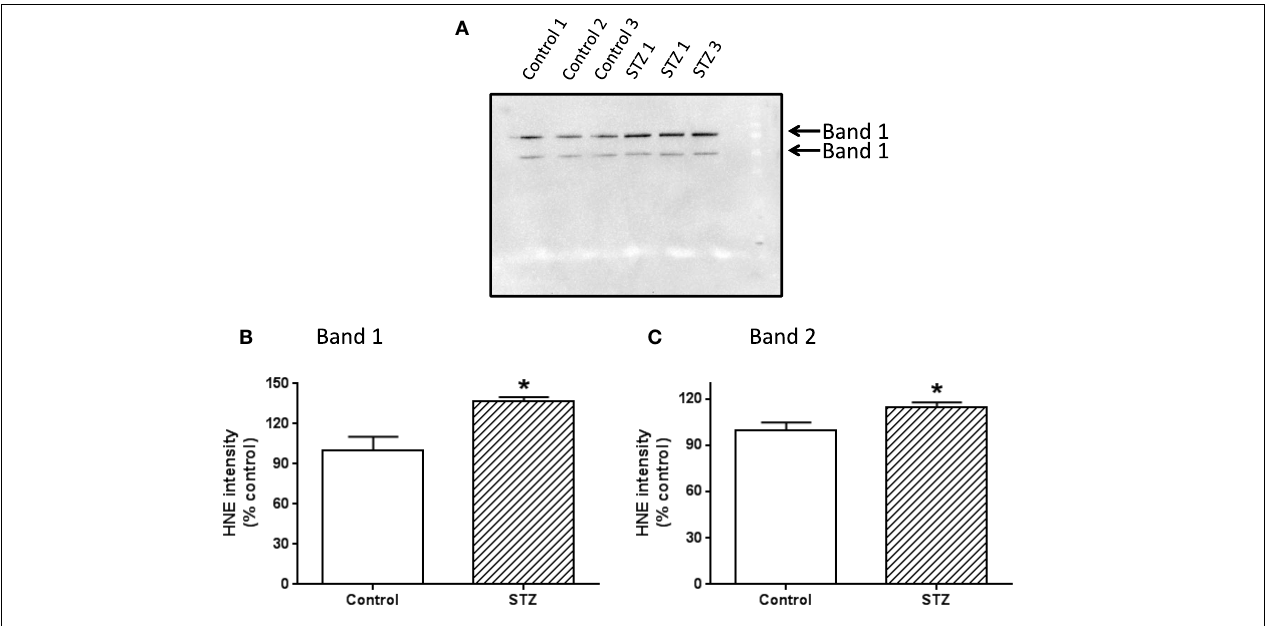
FIGURE 5 | Western blot detection of HNE modification of complex I subunits. Two bands showing HNE modification were indicated in (A) . (B,C) Show the densitometric quantification of HNE content in bands 1 and 2, respectively. P < 0 . 05 indicates significant difference between control and STZ groups.